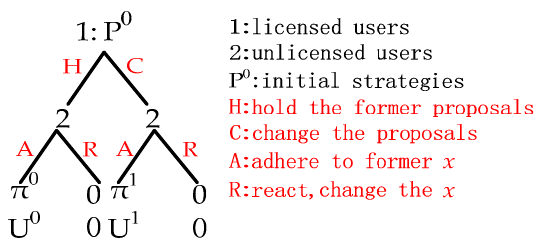
Figure 3. One round of bargaining (the ultimatum game).